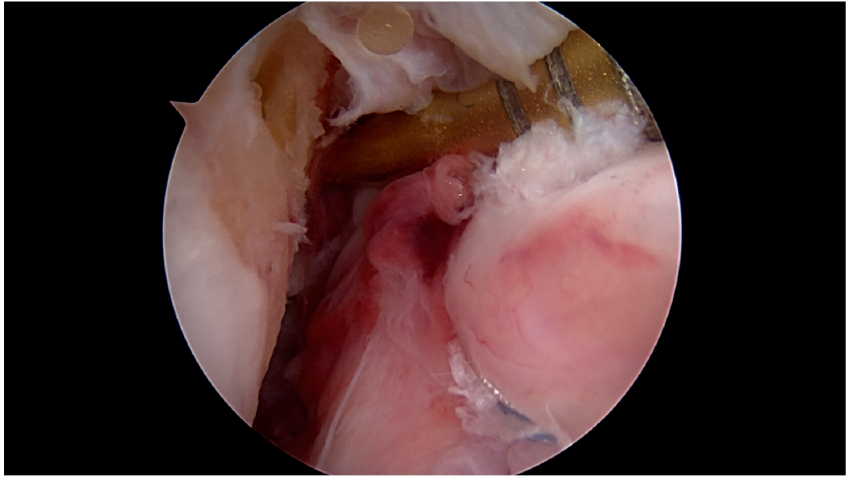
Figure 5. An arthroscopic 45 degree awl is used to perform focused microfracture near the femoral